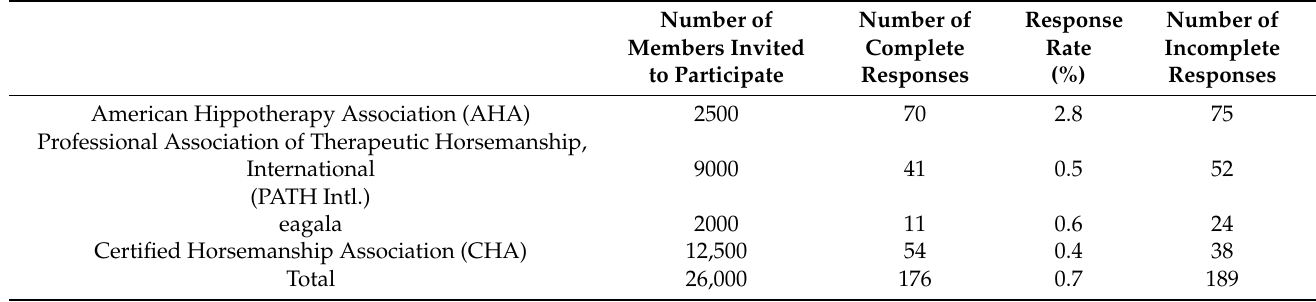
Table 3. Number of responses and response rate by